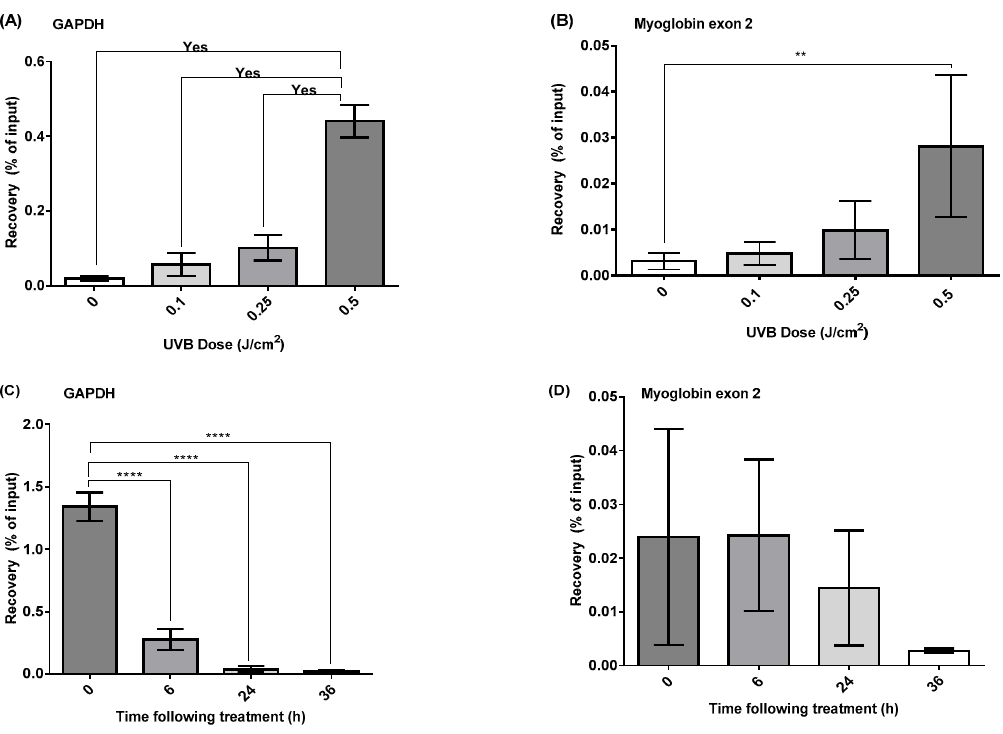
Figure 3. DDIP-qPCR analysis of the induction, and repair, of T<>T in nuclear DNA of HaCaT cells exposed to UVR. DDIP-qPCR for T<>T was performed immediately after exposure using primers specific for the ( A ) GAPDH gene promoter, representative of active genes, and ( B ) for Myoglobin exon 2, representative of inactive genes, using an optimised level of 1 million cells, following increasing doses of UVB. The same assay was then applied to the analysis of T<>T levels in ( C ) GAPDH and ( D ) Myoglobin exon 2 genes, at 0, 6, 24 and 36 h after exposure to 0.1 J/cm 2 SSR. Recovery, which represents the induction/repair of damage, was expressed as a percentage of the amount of immunoprecipitated DNA compared to the input DNA after DDIP-qPCR. The results are the mean ± SEM of three independent DDIP-qPCR experiments, **** p < 0.0001, ** p < 0.001.